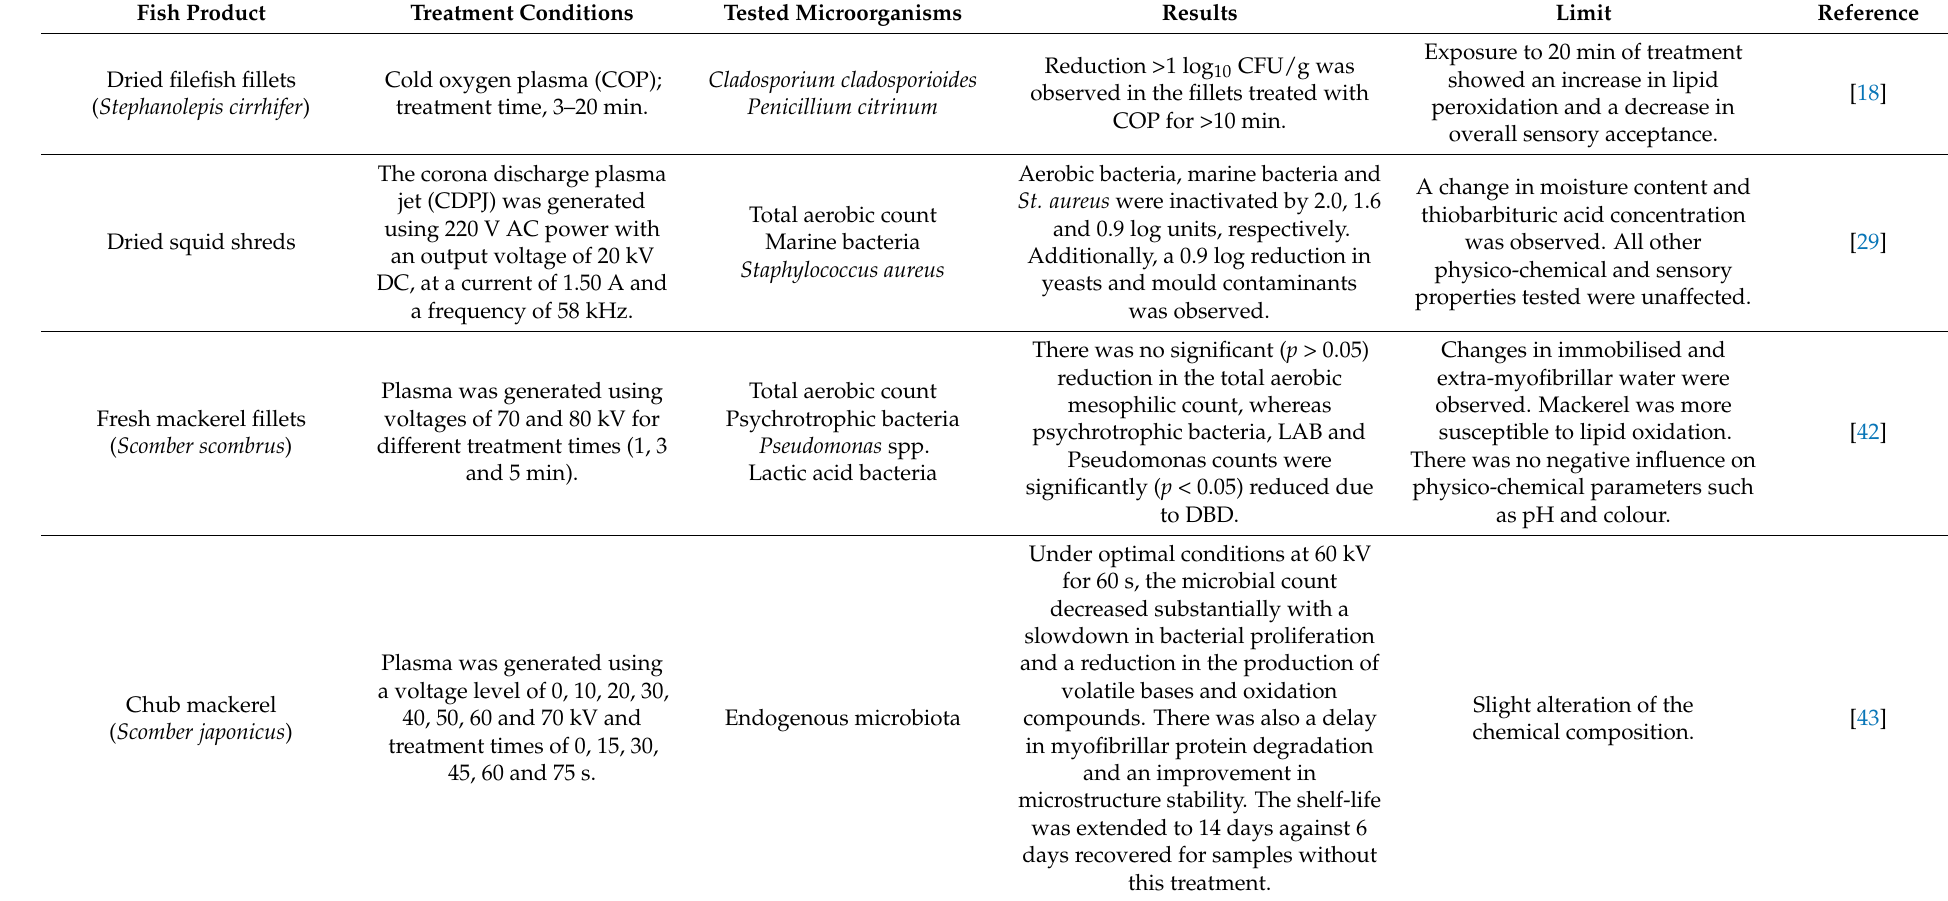
Table 2. Application of non-thermal atmospheric plasma (NTAP) technology to fish products; main results and limitations of the technology